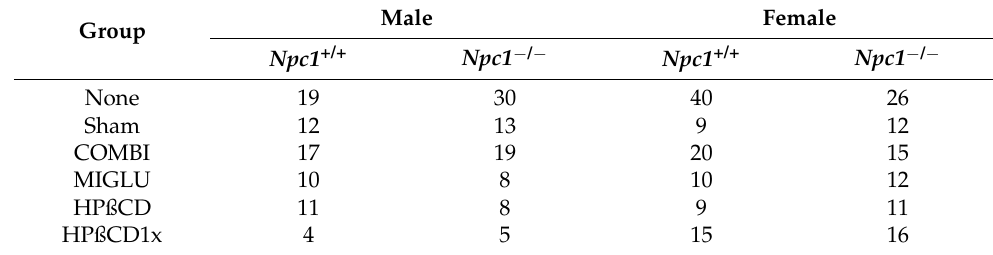
Table 2. Number of male and female Npc1 +/+ and Npc1 − / − mice used in the various treatment groups. Male Group